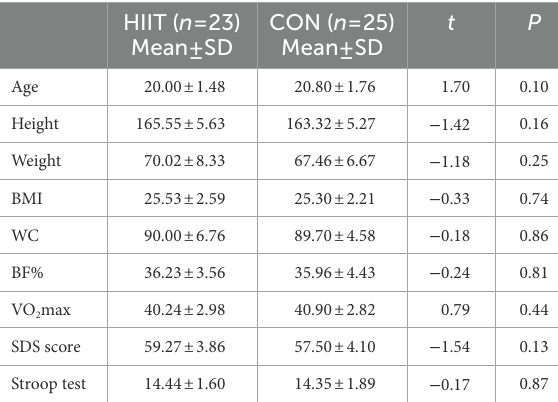
TABLE 2 Baseline data of the